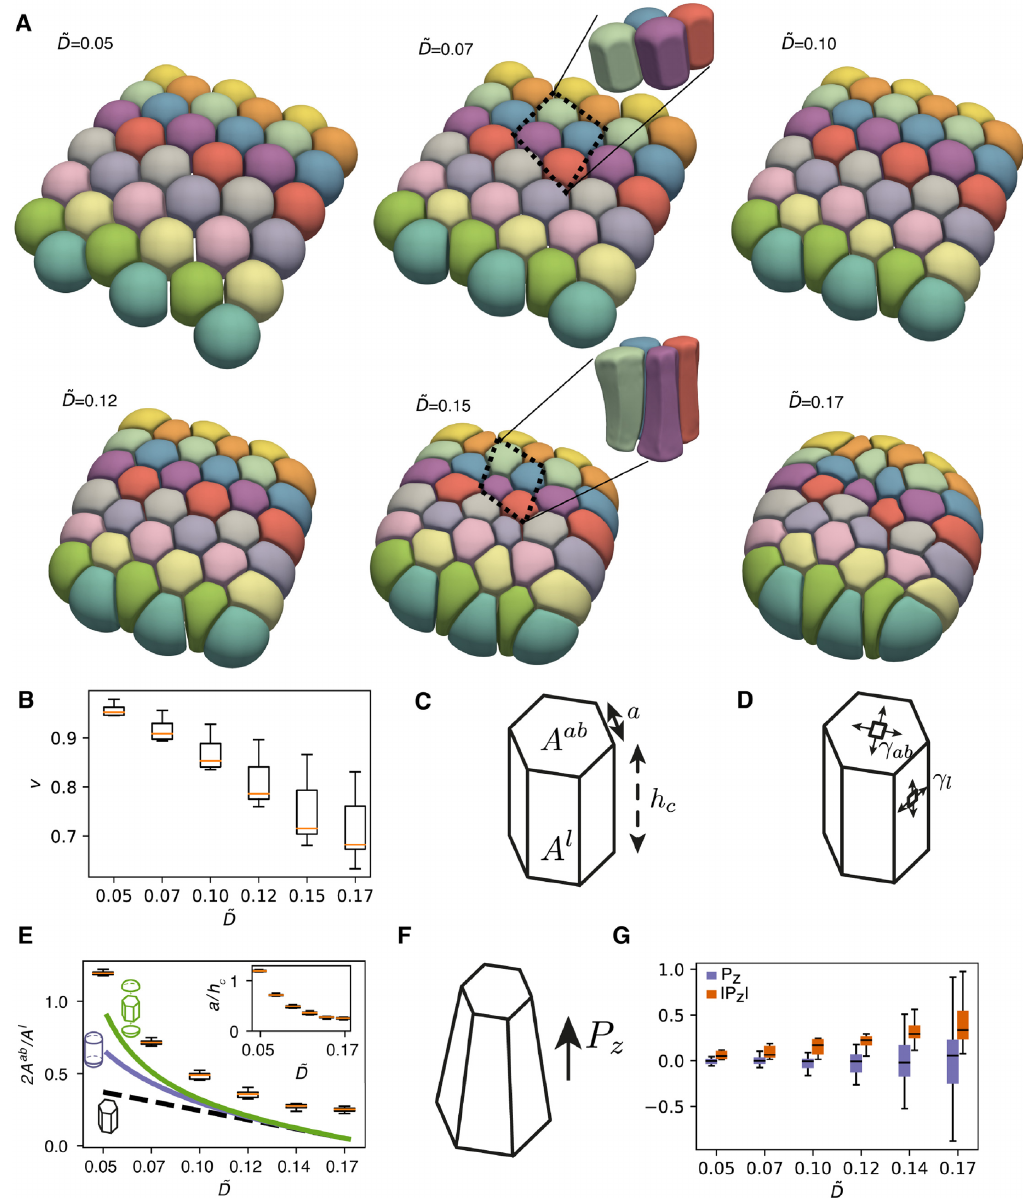
Fig 6. (A) Simulation results (equilibrium shapes) for a planar sheet for different values of the adhesion parameter ~ D ¼ Dr l = � γ ( ~ κ ¼ 10 (cid:0) 2 , ~ l ¼ 0 : 04 ). (B) Reduced volume v as a function of ~ D . (C) Schematic for the measured apical and basal min cell surface area A ab , lateral surface area A l , side length a and cell thickness h model with a lateral surface tension γ l and apical and basal surface tension γ ab . (E) Box plots: ratio of apico-basal to lateral surface area 2 A ab / A l for the center cells, as a function of the adhesion parameter ~ D . Dashed black, blue and green lines: prediction of simplified theories describing the cell shape as an hexagonal prism, a cylinder with two spherical caps, and the union of a hexagonal prism with two spherical caps. Inset: cellular aspect ratio a / h face and h c the thickness of the sheet, as a function of ~ D . Here a ¼ vector P characterising the asymmetry of the cell shape. (G) Box plot for P z (blue) and | P z | (red). As adhesion increases, cells deform asymmetrically in the direction orthogonal to the planar sheet.